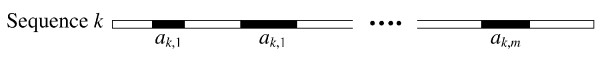
The structure of a sequence containing m ungapped motifs denoted ak,1 to ak,m.